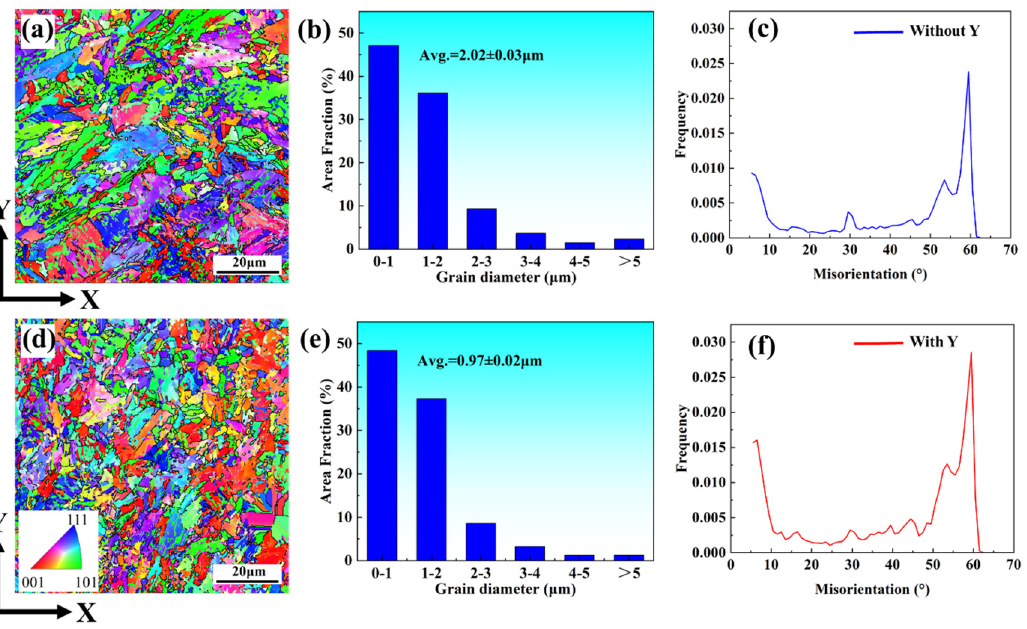
Figure 4. ( a , d ) IPF drawing of the formed parts without and with yttrium, respectively; ( b , e ) grain size distribution of the formed parts without and with yttrium, respectively; ( c , f ) grain boundary angular distribution of the formed parts without and with yttrium.